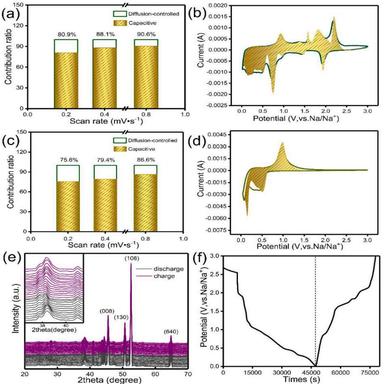
(a) CuS Contribution ratio of the capacitive and diffusion behaviors at various scan rates; (b) Separation of the capacitive and diffusion currentsin CuS at a scan rate of 0.8 mV s − 1 ;(c) ZnS Contribution ratio of the capacitive and diffusion behaviors at various scan rates; (d) Separation of the capacitive and diffusion currentsin ZnS at a scan rate of 0.8 mV s − 1 ; (e) The in-situ XRD patterns of CuS under different charging and discharging cycle in a voltage range of 0.01–3.0 V; (f) The corresponding